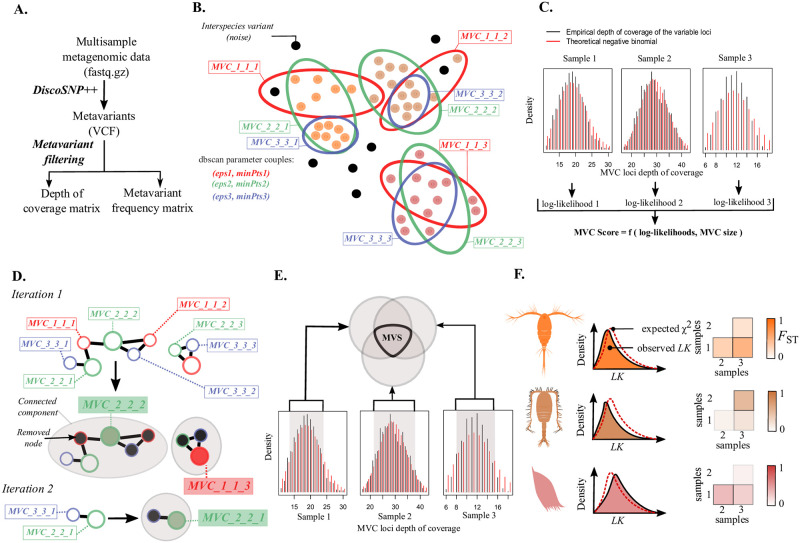
Metavariant species construction from metagenomic data with metaVaR.A. Variant calling from raw metagenomic data. B. Multiple density-based clustering of metavariants mDBSCAN-WMIN. Black points represent inter-species variants, while other colored points refer to unclustered variants. Circle colors represent the dbscan parameters. C. Metavariant cluster scoring. D. Maximum-Weighted Independent Set algorithm. Each node is a cluster of metavariants, their circle color representing the dbscan parameters used to build the cluster. Grey zones represent the connected components. Colored nodes are MWIS and black nodes are MWIS neighbors. E. Metavariant filtering for MVS construction. Grey zones correspond to the single-copy loci. F. Population genomics of MVS.